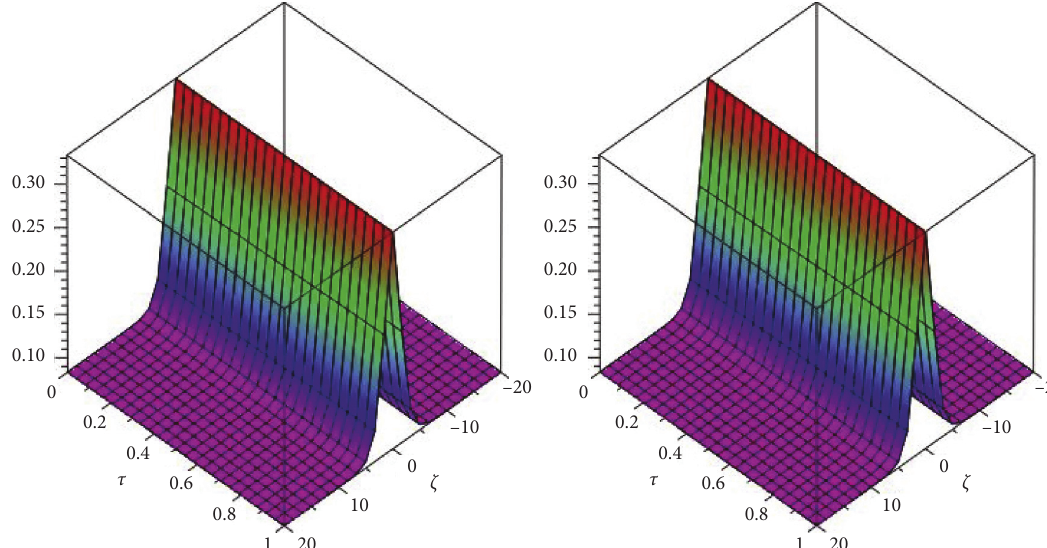
Figure 1: The exact and analytical solutions of Example 1.